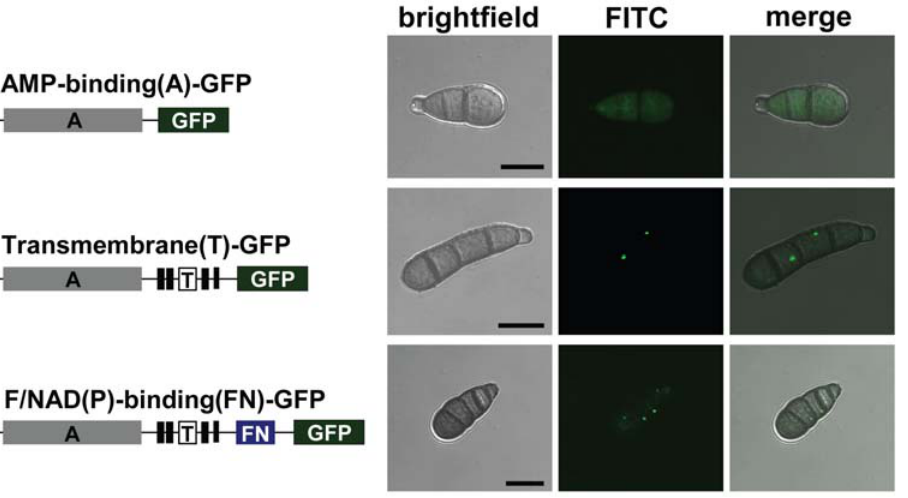
Figure 3. The transmembrane domain of the TmpL protein carries an organelle targeting signal. Organelle targeting of partial or complete TmpL-GFP fusion proteins. At left schematic representations: gray boxes represent the AMP-binding (A) domain of TmpL protein; six tandem black boxes represent the transmembrane (T) domain; and a blue box represents the FAD/NAD(P)-binding (FN) domain. Right micrographs show GFP signal localization patterns of each fusion protein in A. brassicicola conidia. Bars=10 m m.